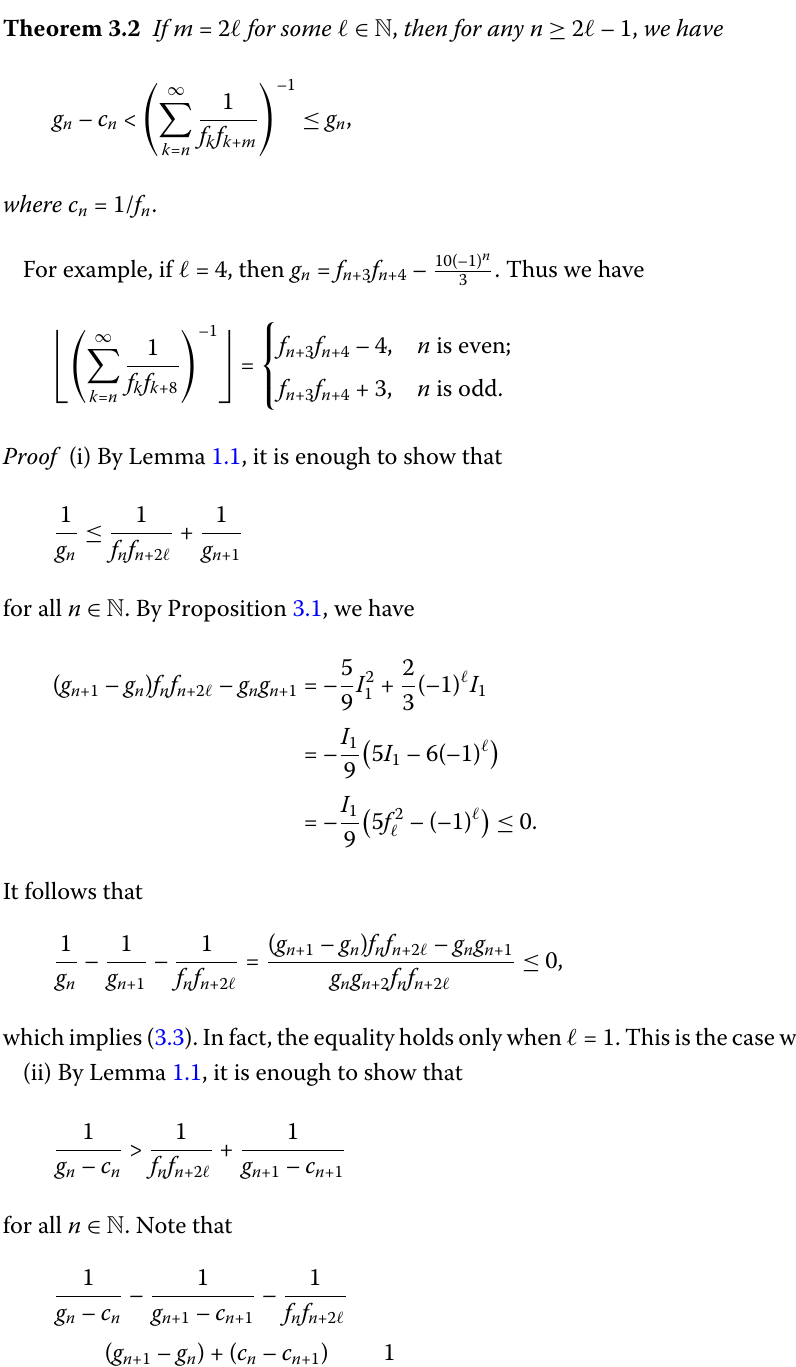
(cid:9) ∞ 1 ) –1 k = n f k f k +4 (cid:9) ∞ 1 ) k = n fkfk +4